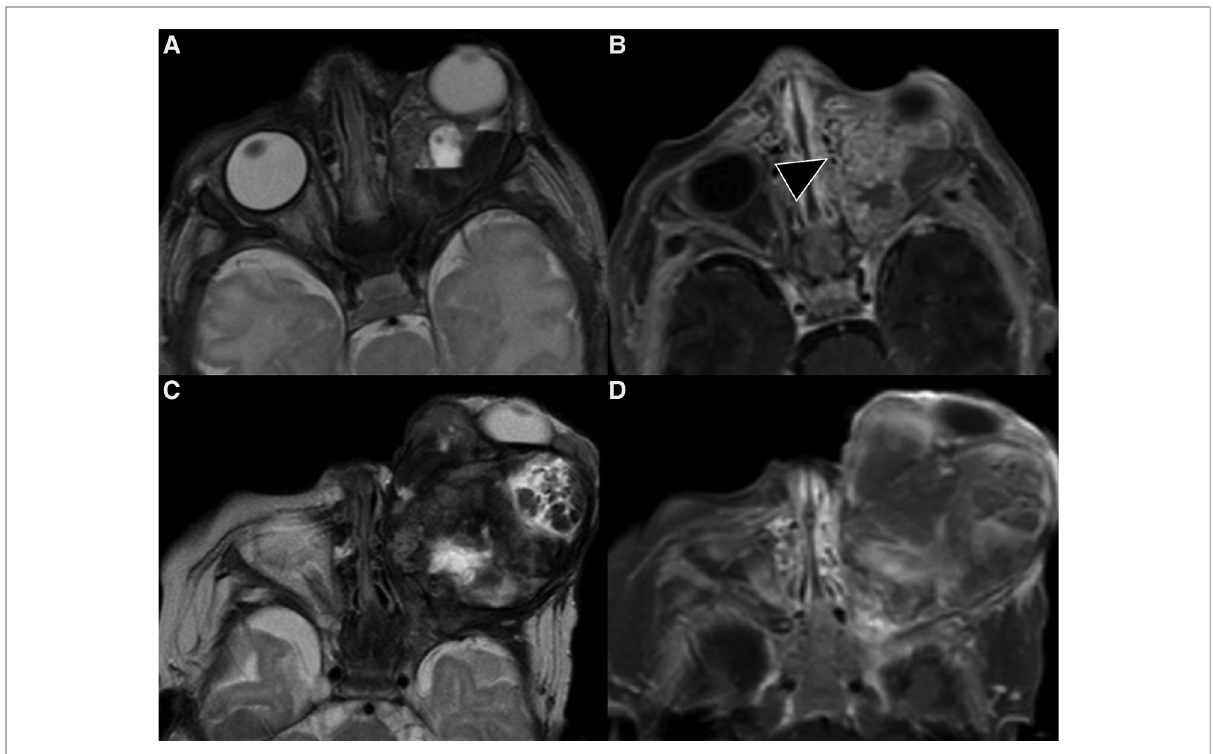
FIGURE 13 One-day-old boy with a congenital lesion of the left orbit. MR performed soon after birth shows a heterogeneous mass with multiple cystic-like components and fl uid-blood levels on T2-weighted images ( A ) and a prominent solid component on axial T1 post-contrast images (black arrowhead in B ); marked proptosis of the left eye is also evident. The lesion undergoes considerable growth after one month ( C,D ). The histological diagnosis was of rhabdomyosarcoma of the orbit.